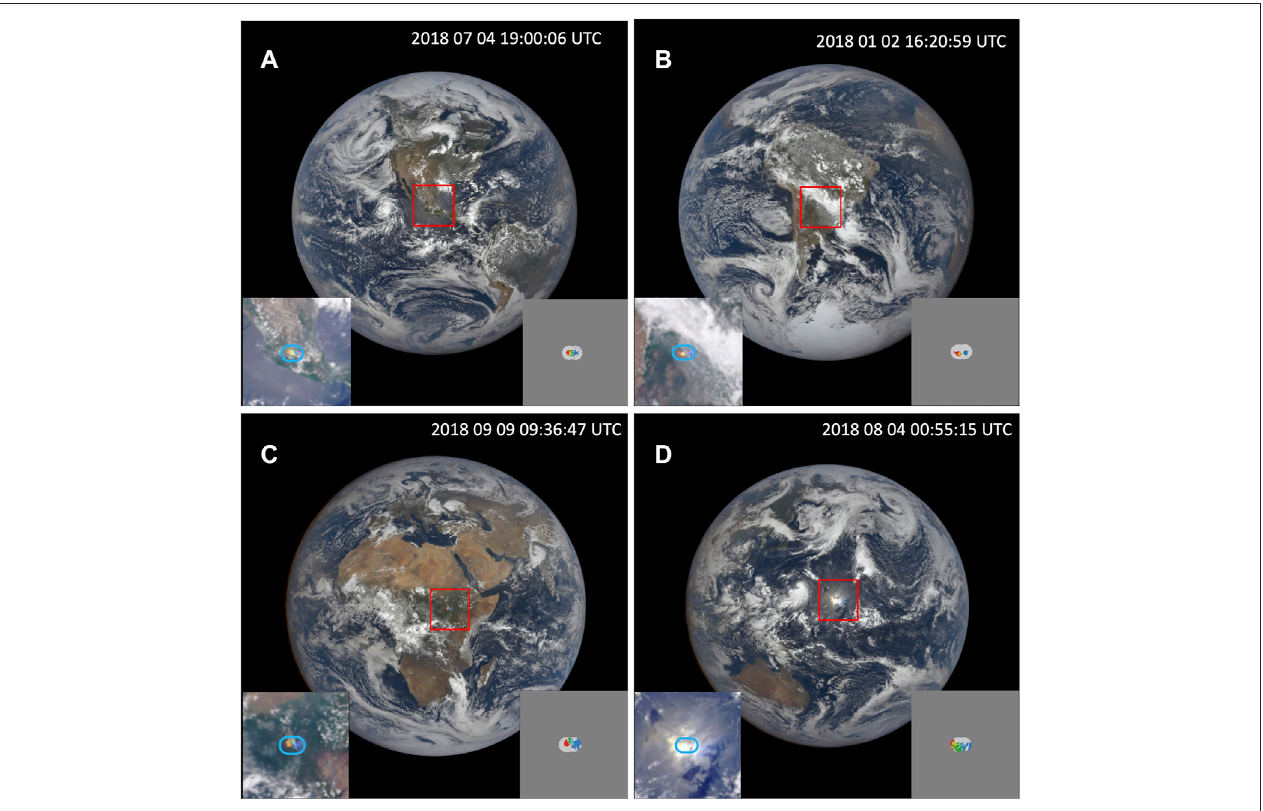
FIGURE 3 | Sample sun glints caused by specular re fl ection from ice crystals in clouds (A – C) and from smooth ocean surface (D) . The insets show the glint- affectedareasindetail (leftinset), aswellastheEPICglintmask (rightinset). Differentcolorsinthisrenderingoftheglintmaskindicatewhichwavelength(s)intheEPIC observations are affected by glint, with yellow and turquoise indicating the overlap of red and green, or blue and green glints, respectively. Light grey means “ no glint ” , while dark gray indicates that no glint detection is attempted as the glint angle exceeds 2 ° .